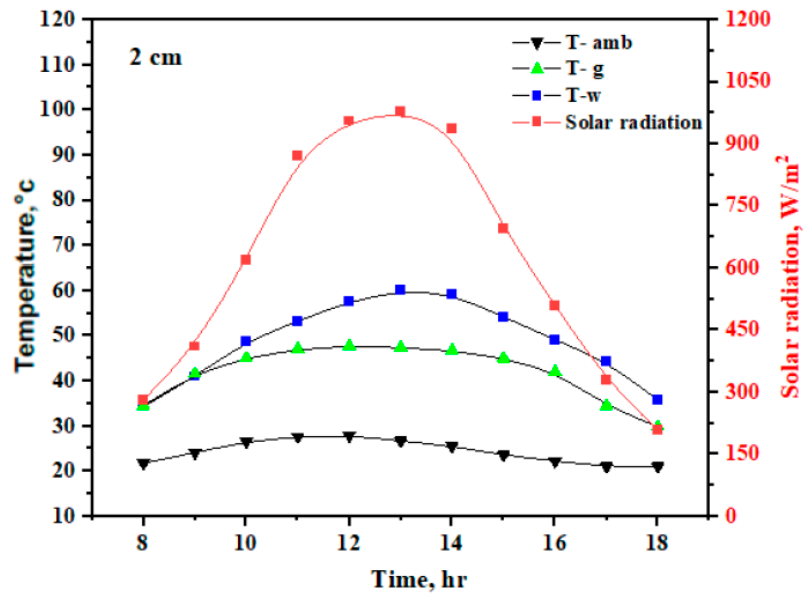
Figure 4. Daily variations of temperature and solar intensity of the still with 2 cm water depth. The daily variations of the basin’s water temperature of the still with a water depth ranging from 1 to 3 cm are plotted in Figure 6. From 8:00 a.m. to 14:00 p.m., the water temperature in the basin is higher at 1 cm than it is at 2 and 3 cm, and then it gradually drops. Rising the water depth from 1 to 2 cm caused a decrease in the basin’s water temperature of up to 4% (from 8:00 a.m. to 14:00 p.m.), and an increase of up to 2% (from 15:00 p.m. to 18:00 p.m.), which has a direct impact on the energy, exergy, and water productivity. Whereas raising the water depth to 3 cm caused a decrease in the basin’s water temperature of up to 9% (from 8:00 a.m. to 14:00 p.m.), and an increase of up to 3.5% (from 15:00 p.m. to 18:00 p.m.). This increase in the basin’s water temperature is due to the energy-storing ability of the water held in the basin.